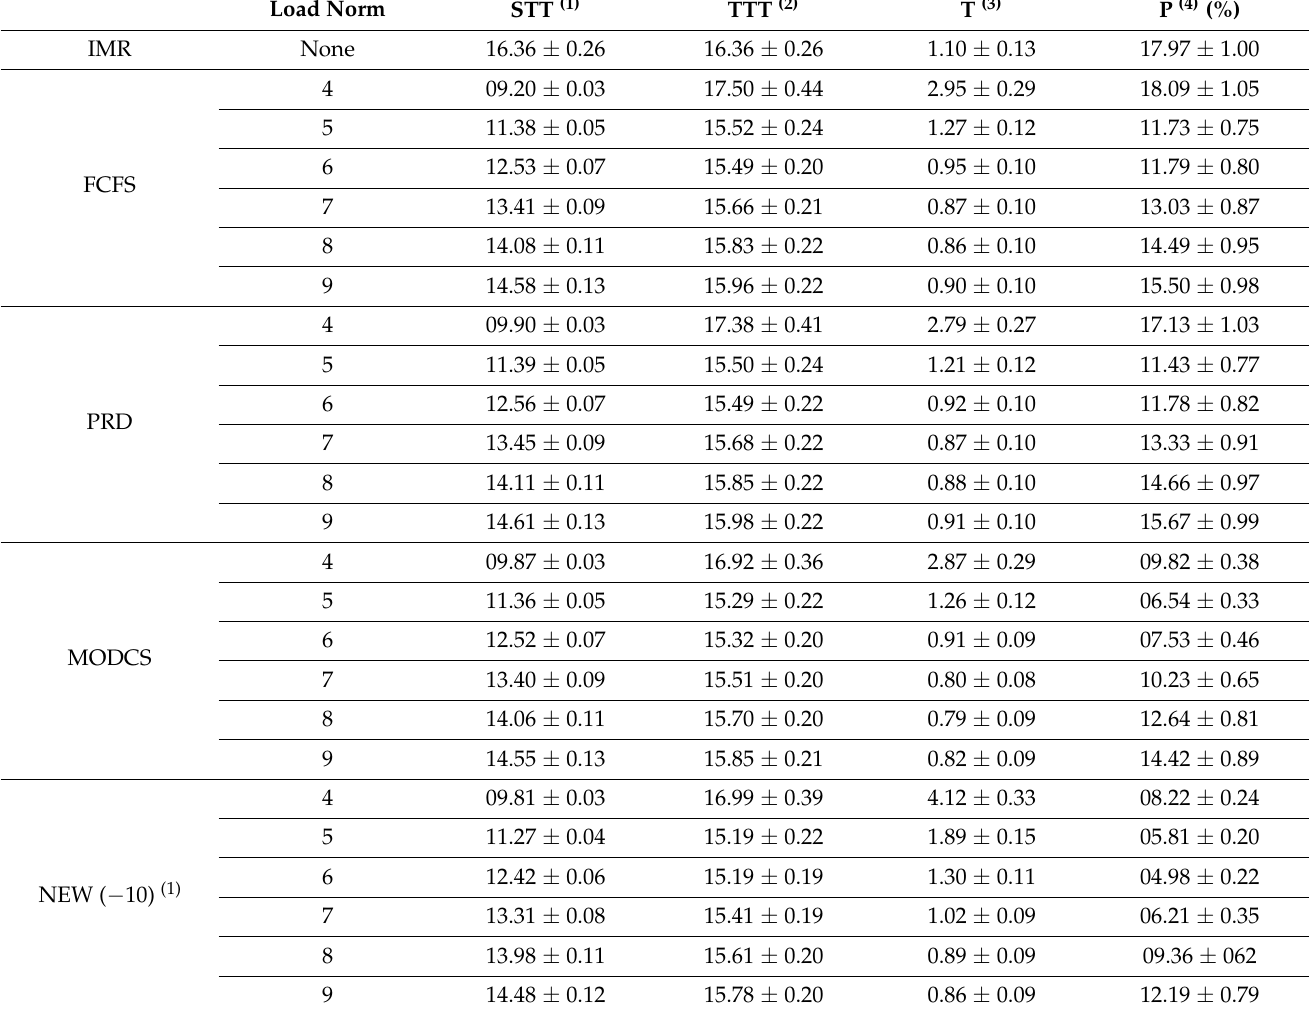
Table 7. Simulation results for CV =